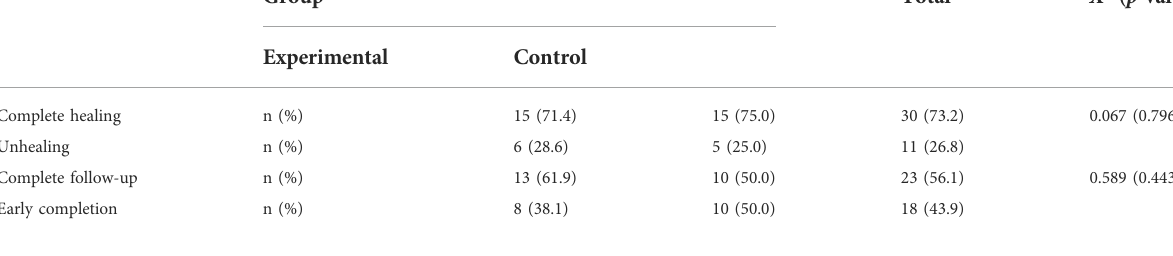
TABLE 2 Statistical comparison of treatment results between both groups.